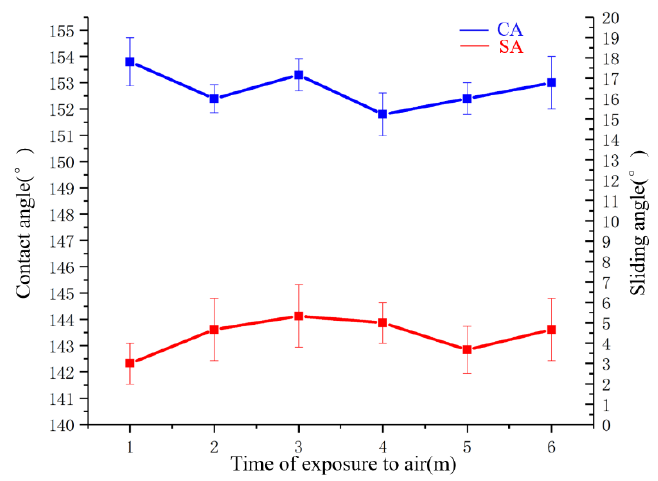
Figure 15. CA and SA of coatings exposed to air at different time.